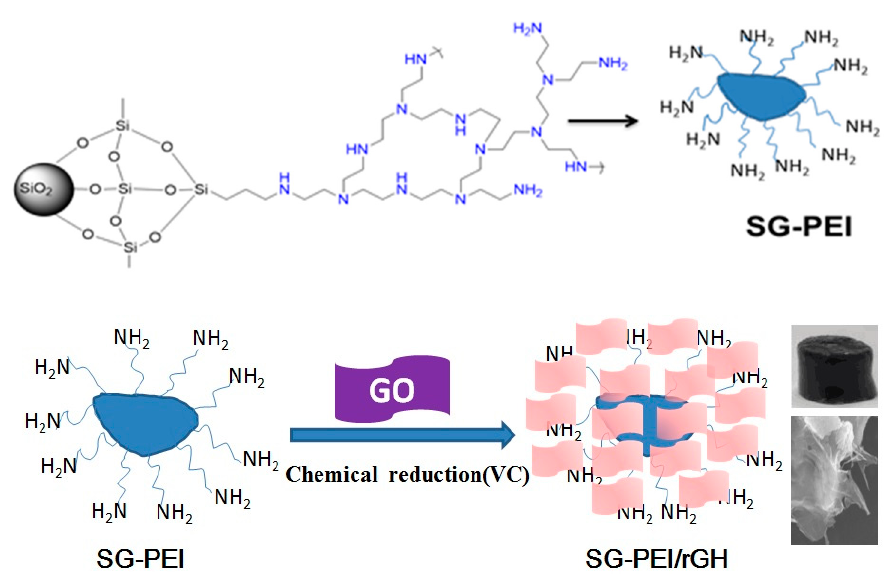
Figure 1. FTIR spectra of ( a ) SG-PEI and ( b ) SG-PEI/rGH composite